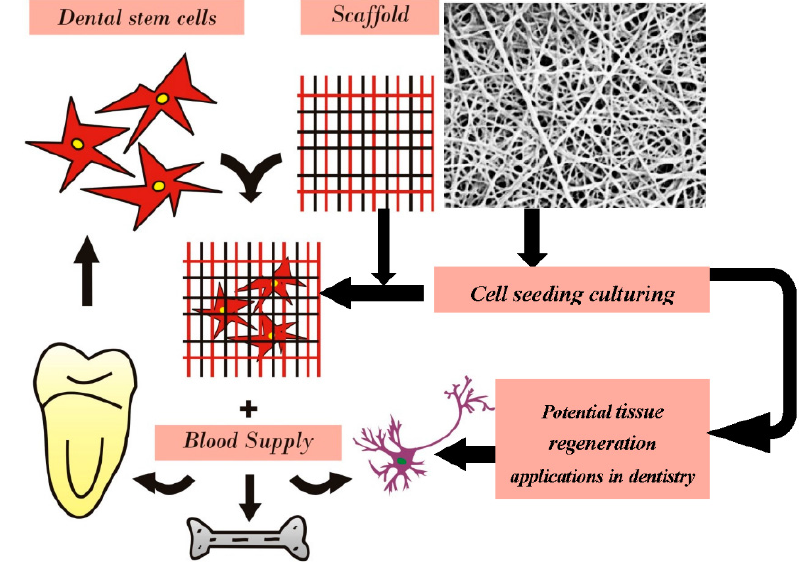
Figure 3. Schematic presentation of using electrospinning scaffolds for tissue engineering of various oral and dental tissues. Table 3. Potential and progress of electrospun materials for dental applications.